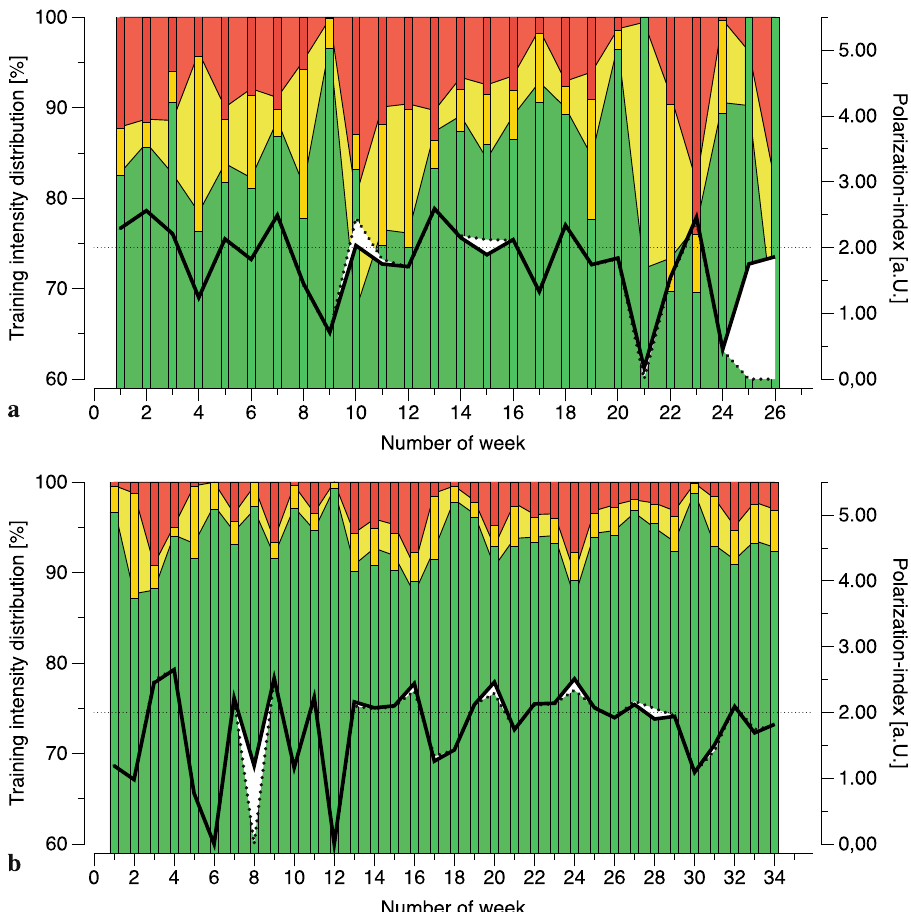
Figure 3. ( a , b ) Exemplary analysis of two athletes’ training monitoring over a period of 26 ( a ) and 34 ( b ) weeks. Green, yellow and red bars indicate the training intensity distributions (TID) as percentages of the labeled training (TRAIN ≥z1 ) assigned to zones 1 (60 ≤ 82% of maximum heart rate, green), zone 2 (82 ≤ 88%, yellow), and zones 3 (88–100%, red), respectively. The background areas in similar colors indicate the TID, derived from the total training volume (i.e., labeled training plus activities during daily living with heart rates ≥ 60% of the maximum, TOTAL ≥z1 ). The black line indicates the polarization index of the total training (according to Treff et al. 21 ) while the dashed line shows the labeled training, only. The shaded area highlights differences in the polarization index between the labeled and the total